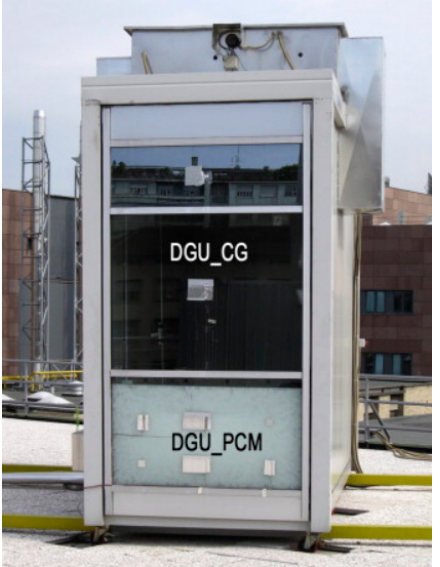
Figure 15 . Schematic diagram of an installation for comparing a classic insulating glass unit and an insulating glass unit with phase-change materials (data from ref. [132,135]) . The measuring system consisted of 40 sensors. The sensor system measures the phys- ical parameters of the double-glazed windows. Climatic conditions inside and weather conditions outside the chamber are also recorded by sensors. The tests were carried out for six months. The change in the appearance of paraffin glazing during the day can be observed in Figure 16, which shows changes in the aggregate state, as well as changes in the transpar- ency of paraffin in the façade during measurements from 10:00 to 19:00 [136]. Measure- ments were taken every hour. The results were obtained in summer during sunny